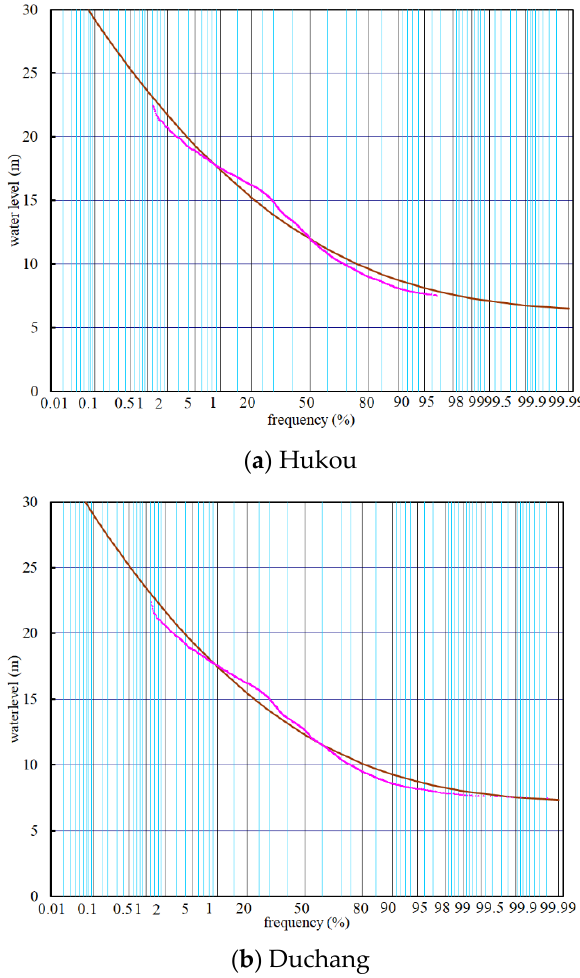
Figure 6. P-III water level frequency curves of ( a ) Hukou station and ( b ) Duchang station: the purple dots represent empirical points, and the brown lines represent theoretical frequency curves.